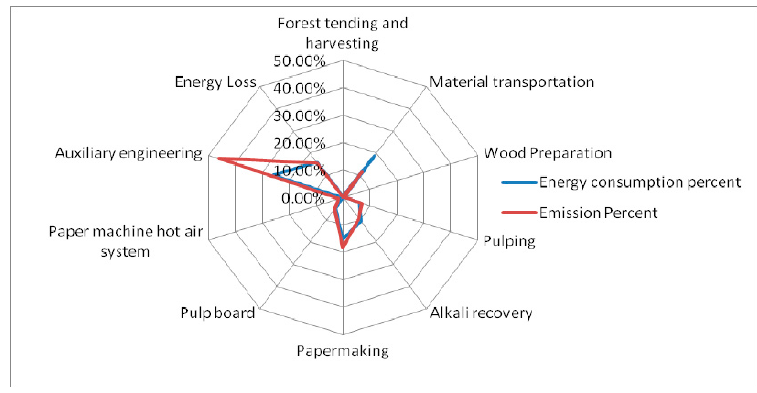
Figure 12. Comparison of energy consumption and carbon emissions in major production processes.